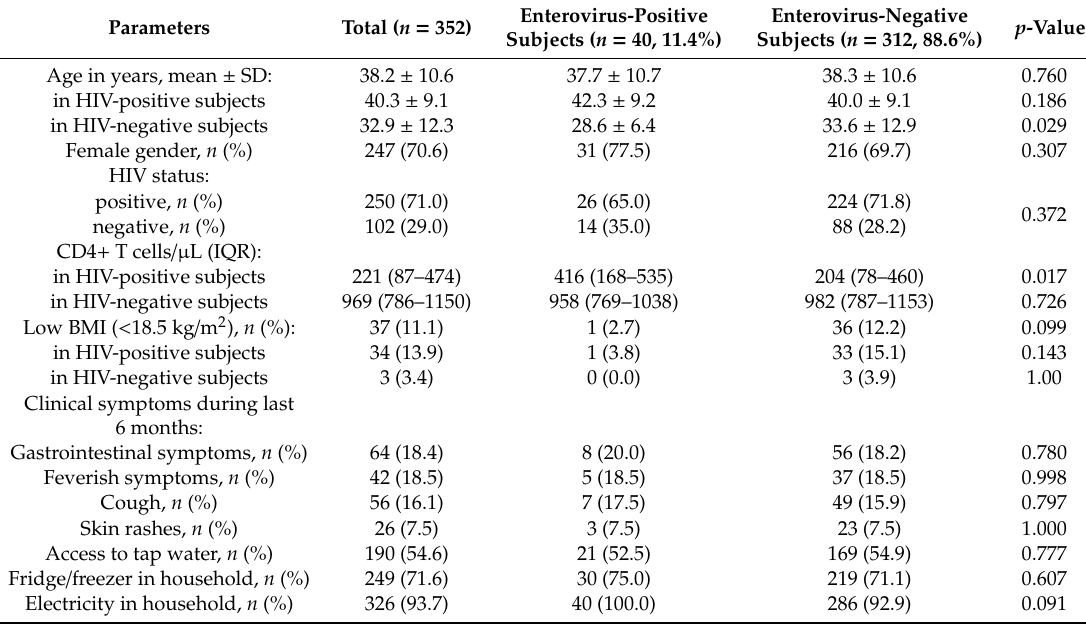
Table 1. Demographical and clinical characteristics of enterovirus-positive and enterovirus- negative